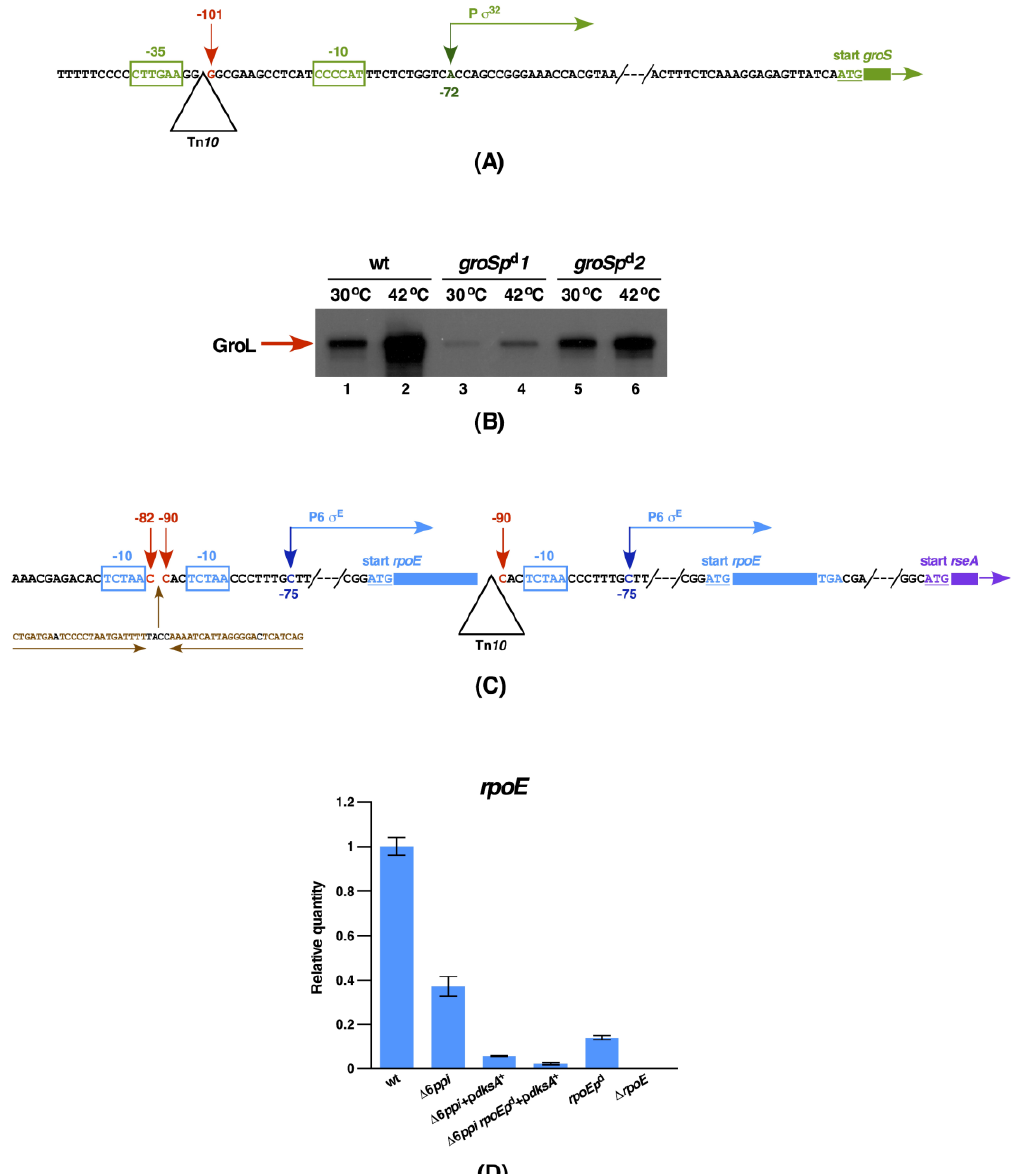
Figure 11. Wild-type expression of GroL and RpoE are required for the DksA-mediated suppression of either ∆ 6 ppi or ∆ dnaK / J bacteria. ( A ) Schematic drawing of the Tn 10 insertion position in the promoter region of the groS / L operon. Boxes indicate the location of − 10 and − 35 heat shock elements recognized by RpoH. ( B ) Western blot analysis of total cell extracts obtained from the wild type (wt) and its two isogenic derivatives carrying groSp d 1 and groSp d 2 mutation with or without a heat shock of 15 min at 42 ◦ C. Equivalent amounts of proteins were applied and resolved on 12.5% SDS-PAGE and transferred by Western Blotting. Blots were probed using GroL-specific antibodies and revealed by chemiluminescence. ( C ) The position of the Tn 10 insertion at the nt position − 90 in the rpoE P6 promoter is indicated. The duplication and the orientation of the intact rpoE gene and the disruption of the rpoE P6 promoter is shown by an arrow. ( D ) Quantification of the rpoE mRNA by qRT-PCR using the total RNA isolated from the isogenic wild type (wt), SR18292 ( ∆ 6 ppi ), SR20561 ( ∆ 6 ppi + p dksA + ), GK5165 ( ∆ (6 ppi rpoEp d ) + p dksA + ), GK5347 (wt rpoEp d ) and SR8691 ( ∆ rpoE ) strains. For RNA isolation, cultures were grown under permissive growth conditions of M9 at 37 ◦ C. at the Tn 10 insertion site in the same orientation (Figure 11C). Further analysis of the rpoE gene expression by quantitative reverse transcription PCR (qRT-PCR) revealed that this Tn 10 insertion leads to a 10-fold reduction of its transcription, which is further reduced when the dksA gene is